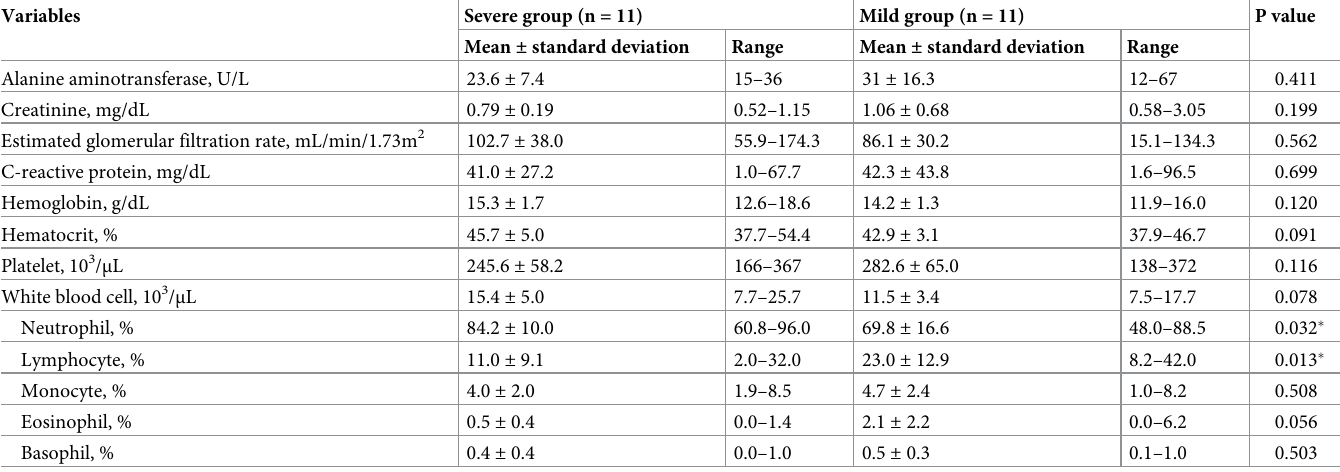
Table 3. Laboratory data of patients with caustic gastrointestinal tract injury (n =